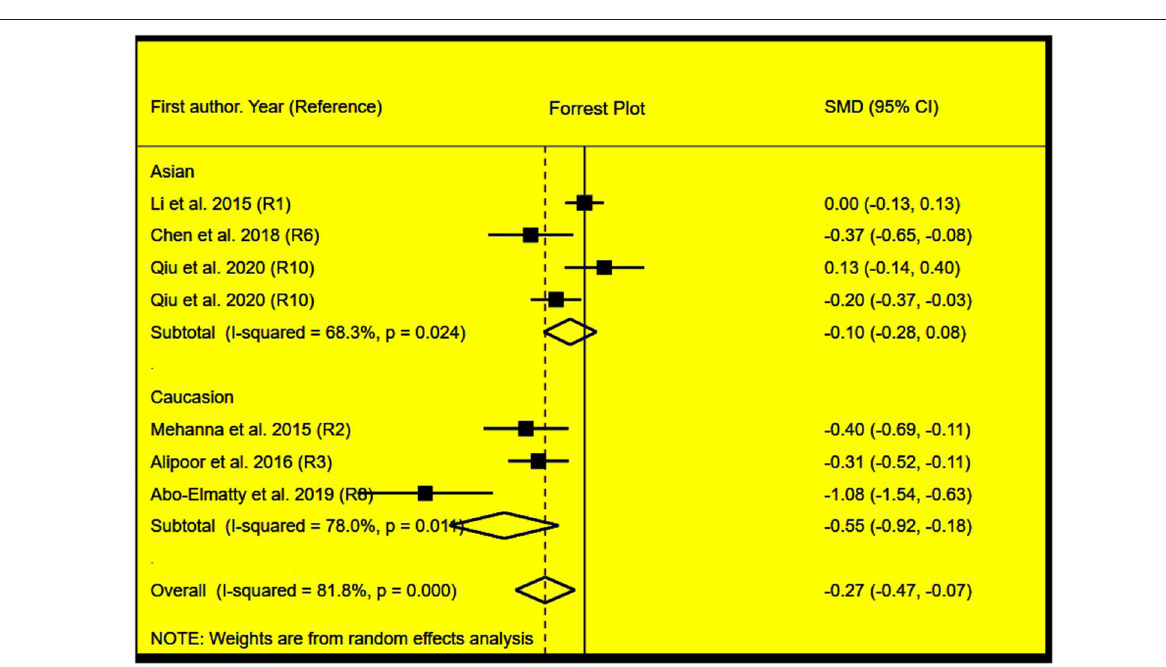
as the main contributors to TG, TC, LDL-C, and HDL-C heterogeneity, respectively. SMD values and 95% CIs of TG, TC, and HDL-C did not change substantially after excluding these